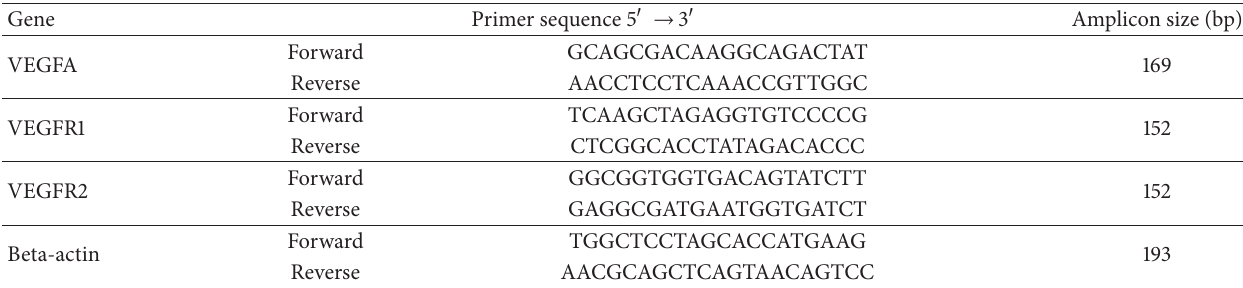
Table 2: Primers sequence for real-time PCR (mice